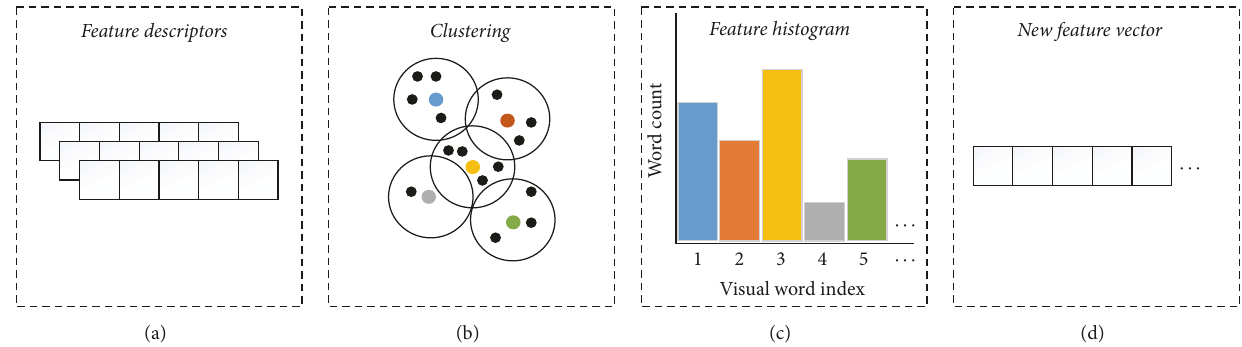
Figure 5: The bag of features diagram: (a) the feature descriptors extracted from images, (b) clustering, (c) the formation of word frequency statistics histogram, and (d) the new feature from the feature histogram.